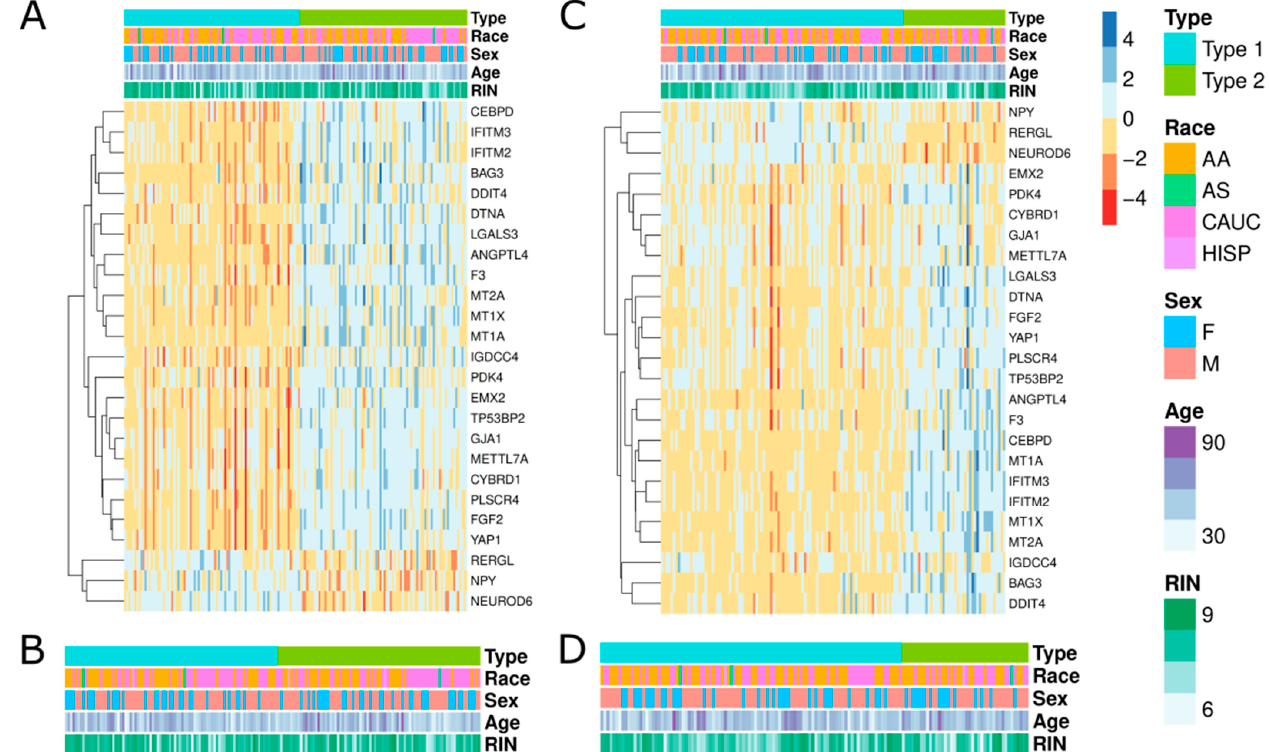
Figure 1. Two schizophrenic clusters identified in multiple RNAseq datasets. ( A , C ) Heatmaps for polyA and riboZ, respectively, showing the top forty genes with the highest log fold change (LogFC) across all schizophrenic patients. Clustering of the genes and subjects are shown at the side and top of the heatmaps, respectively. ( B , D ) Enlargement of the color bars in ( A , C ). Refer to the color bar on the side for color definitions. AA = African American, AS = Asian, CAUC = Caucasian, HISP = Hispanic, F = Female, and M = Male.